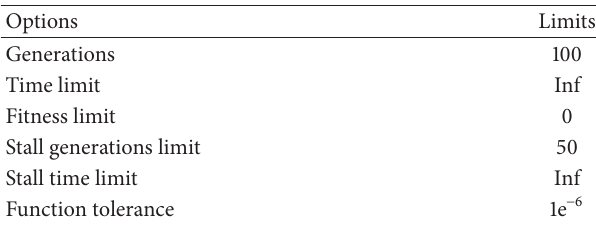
Table 2: Criteria for termination of GA.